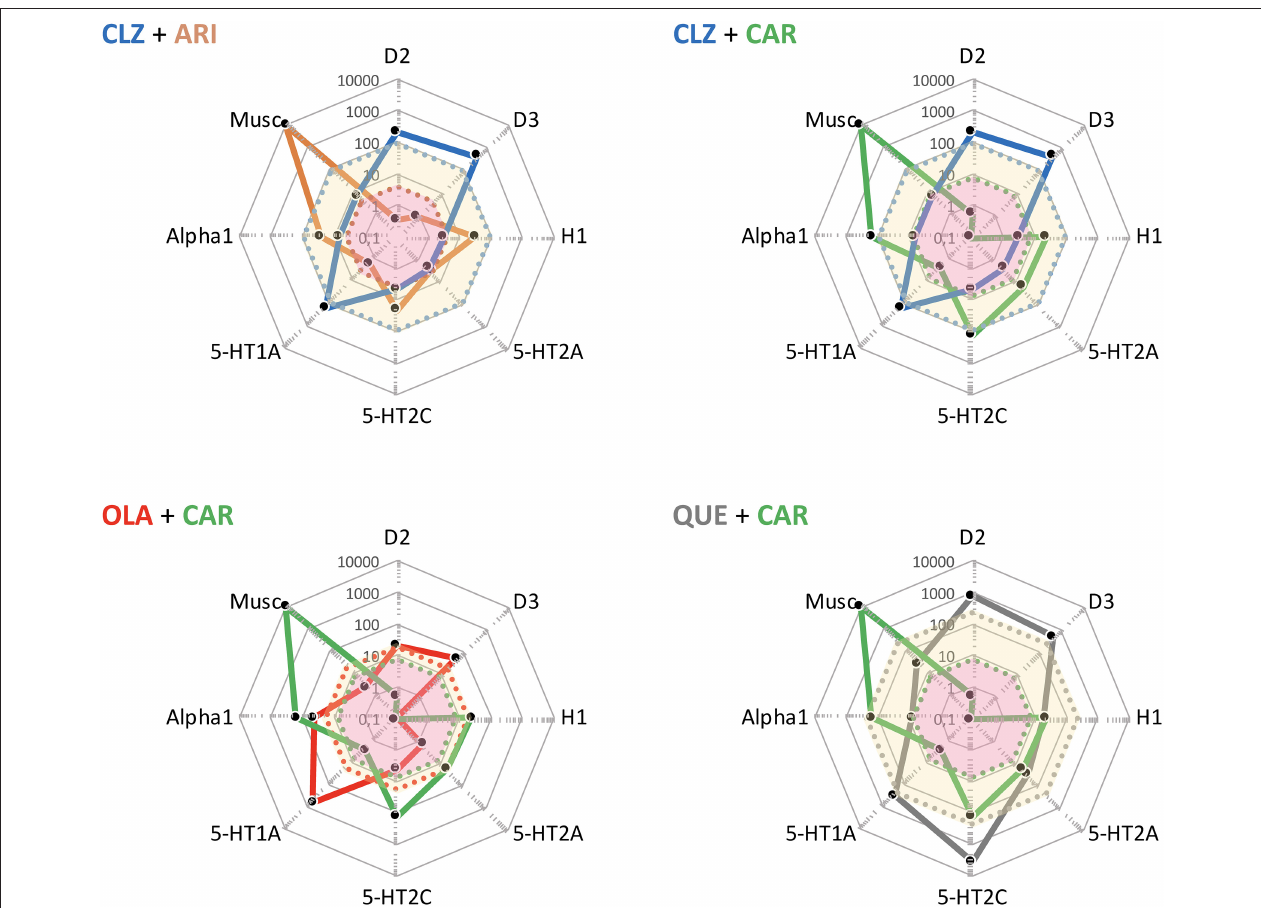
FIGURE 5 | Some potentially useful APP target combinations based on FGA, SGA, and TGA. Shown are target profiles of APP combination examples based on CLZ, OLA, QUE, ARI, and CAR, displayed in a cobweb design. The colored lines joining the dots represent the target profile of the agent with corresponding color coding; e.g., blue is CLZ, and green is CAR. The dot line-enclosed shaded areas represent unbound plasma concentrations of the compounds at therapeutic dosing. For example, in the OLA + CAR case, the yellow and pink areas show unbound OLA and CAR plasma concentrations, respectively. For further explanations, see legend to Figure 4